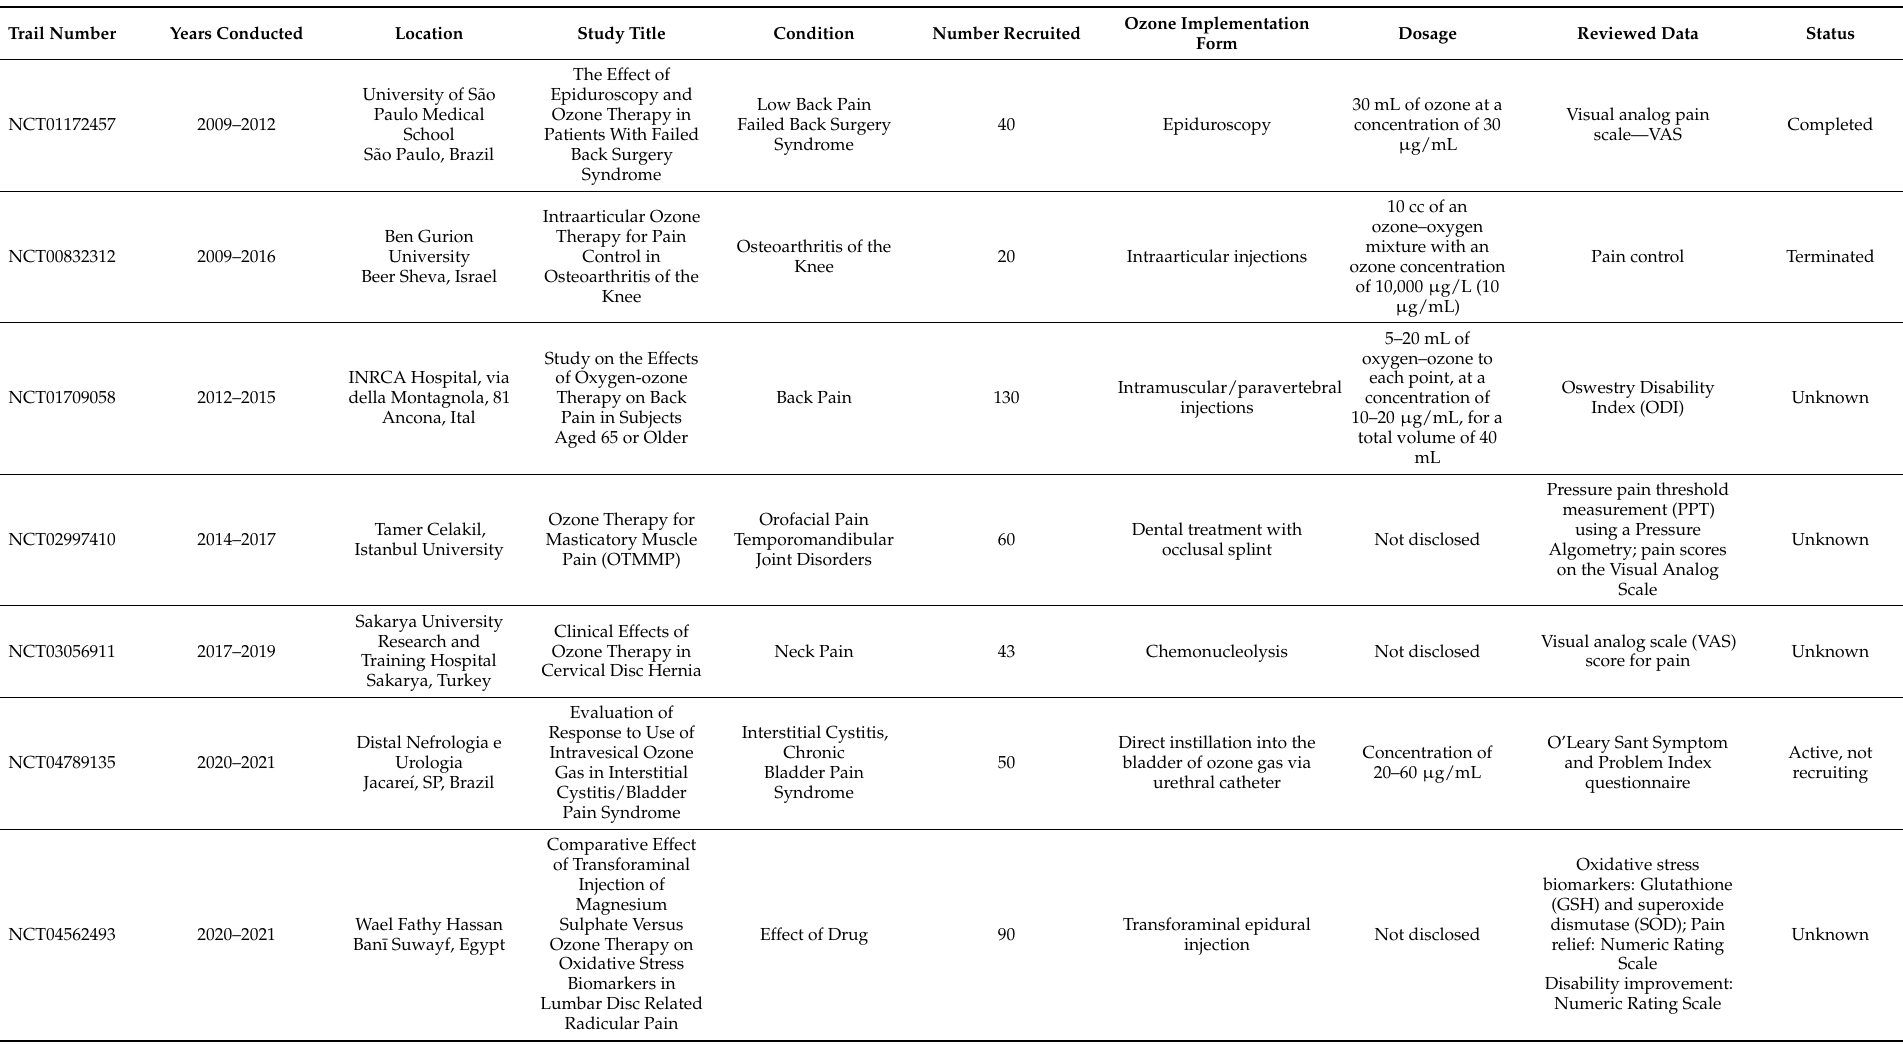
Table 1. Clinical trials on pain treatment with